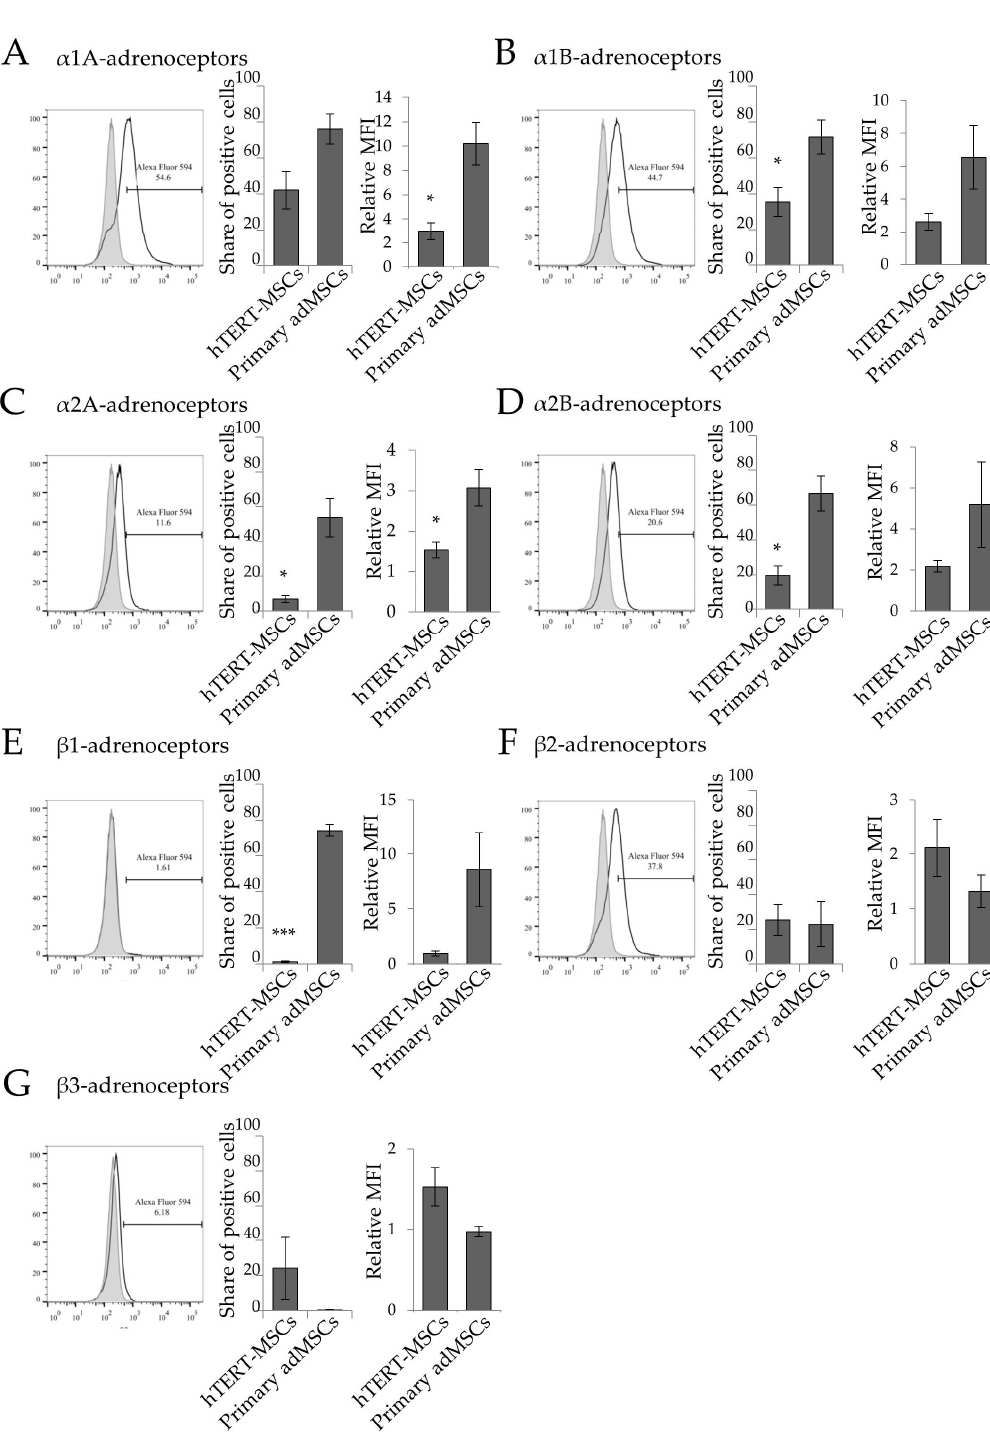
Figure 2. Flow cytometry analysis of adrenergic receptors expression at the hTERT-MSCs surface. Representative flow cytometry histograms and comparative statistical analysis of α 1A- ( A ), α 1B- ( B ), α 2A- ( C ), α 2B- ( D ), β 1- ( E ), β 2- ( F ), and β 3-adrenoceptors ( G ) expression in hTERT-MSCs and primary MSCs are shown [7]. Comparison of share of cells expressing particular adrenergic receptors are shown at the left diagrams in every section of figure. Comparison of relative median fluorescence intensity (MFI) are shown at the right diagrams in the everu section. Mean ± SEM, comparisons of share of positive cells and relative MFI of α 1B-, and α 2B-isoforms were performed using Mann–Whitney U-criteria (M-U test) because of abnormal distribution of the data. Comparisons of other data were performed by Student t -test. n = 3 for hTERT-MSCs and n = 4–9 for primary adMSCs. * p < 0.05, *** p < 0.001.